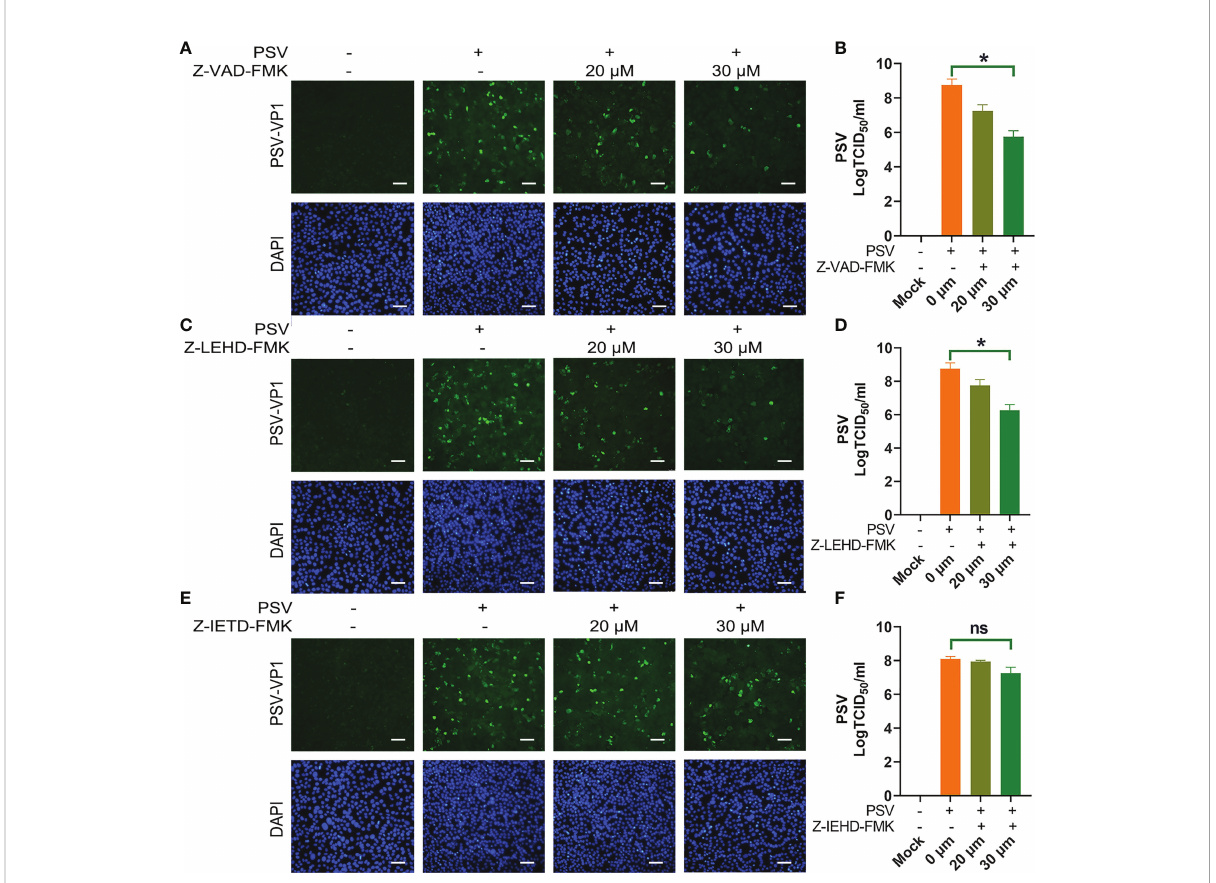
FIGURE 4 Caspase inhibitors affect PSV infection. (A) ST cells were treated with Z-VAD-FMK and infected with PSV. After 24 h, cells were fi xed and incubated with anti-PSV-VP1 antibody and DAPI, followed by examined using fl uorescence microscope. Scale bar: 100 m m. (B) After 36 h, the viral titers were determined by the Spearman-Kärber method, and three independent experiments were expressed as the mean ± SD. *P < 0.05. (C-F) The PSV replication in the presence of Z-LEHD-FMK and Z-IEHD-FMK. *P < 0.05; ns, no signi fi cant